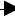
Fig. 12a–d. Distribution of a, b winter and c, d summer drifters through the initial 100 days after deployment a, c across-slope, b, d along-slope, in 10 km bins calculated at 1/2 day periods. The three circles are coloured as in Fig. 3. In b the solid bar at 522 km along-slope after day 40 is the consequence of a stagnat- ing drifter over the Faeroe Bank (522 km being the along-slope distance of the Wyville Thomson Ridge from the release position).